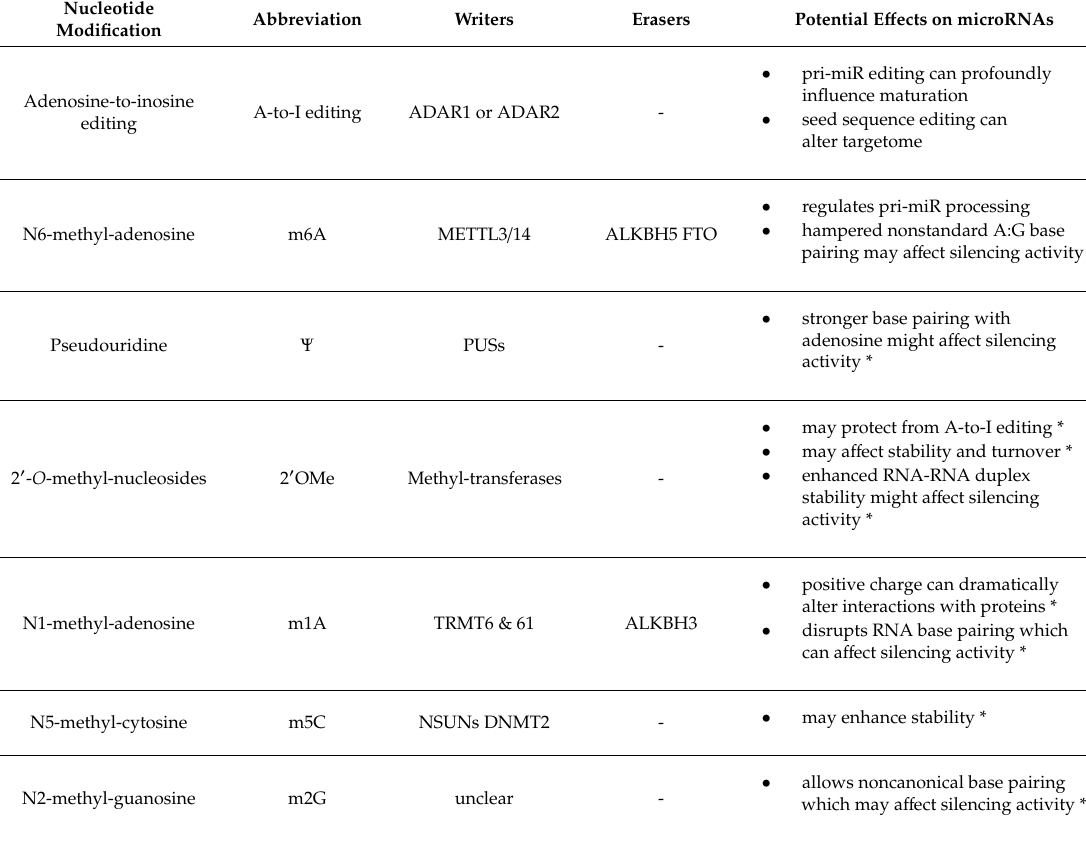
Table 2. Known or postulated e ff ects of nucleotide modification within